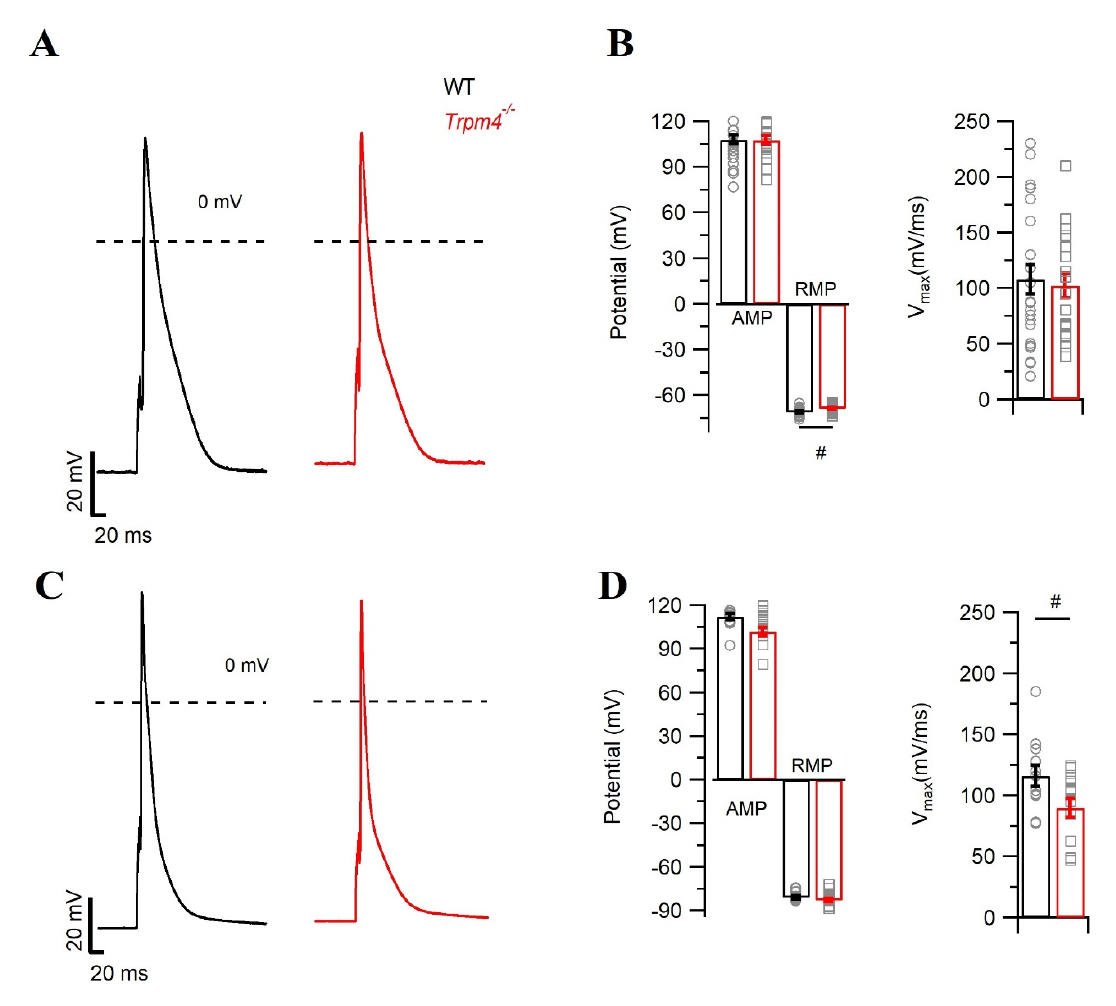
Figure 2. Action potential measurement in isolated mouse atrial and ventricular myocytes. Representative traces of AP recorded in WT (black) and Trpm4 −/− (red) mice either from ( A ) right atrial myocytes ( N = 5, n = 19) or ( C ) ventricular myocytes ( N = 5, n = 14). Average values for AMP (peak amplitude), RMP, V max in WT (circle, black), and Trpm4 −/− (square, red) either from ( B ) right atrial myocytes or ( D ) ventricular myocytes. Note: #: p < 0.05, WT vs. Trpm4 −/− .